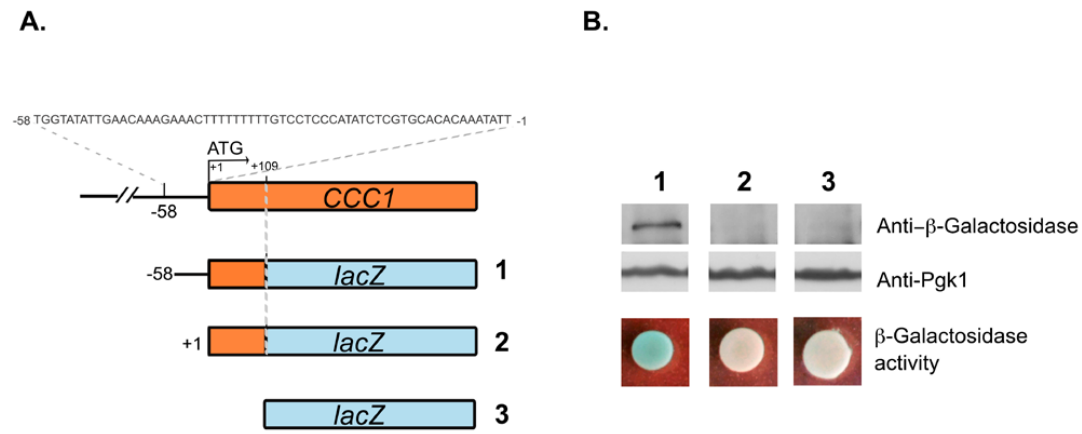
Figure 2. The 58 bp region located immediately upstream the translation initiation codon of CCC1 has promoter activity. ( A ) Schematic representation of the plasmids 1 (yEp356R − 58), 2 (yEp356R+1) and 3 (vector yEp356R). In 1, the 58 bp region of CCC1 promoter along with the first 109 bp of the coding sequence of CCC1 were cloned in frame with lacZ . In 2, only the 109 bp region was cloned in frame with the reporter gene sequence. ( B ) Wild type cells were transformed with plasmids 1, 2 or 3 and β -galactosidase levels were detected by immunoblotting, using an anti- β -galactosidase antibody. Pgk1 levels were used as a loading control. β -galactosidase activity was assayed by spotting 3.5 × 10 7 stationary phase cells transformed with the indicated constructs in SD plates. Plates were incubated at 30 °C, until the development of blue color, after overlay with X-gal/agarose mixture.